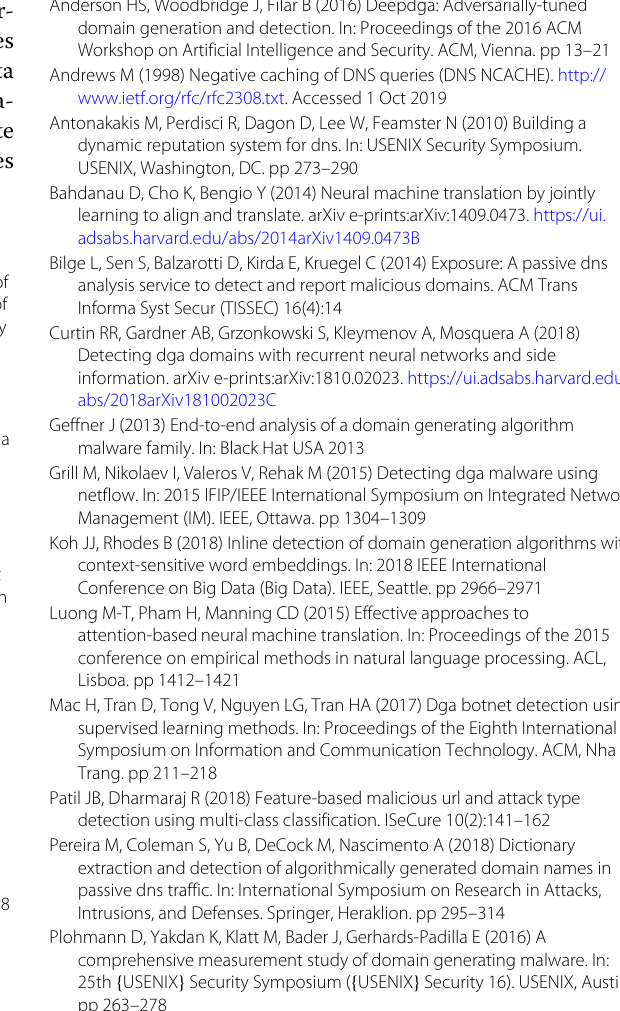
Future work will be focused on the integration of this neural model as part of a system to detect the cyber- threats in real traffic data. Since the DGA domain names is relatively small, we also intend to collect more DGA data and add some side information such as WHOIS informa- tion to improve classification accuracy and differentiate the DGA families that generate similar domain names